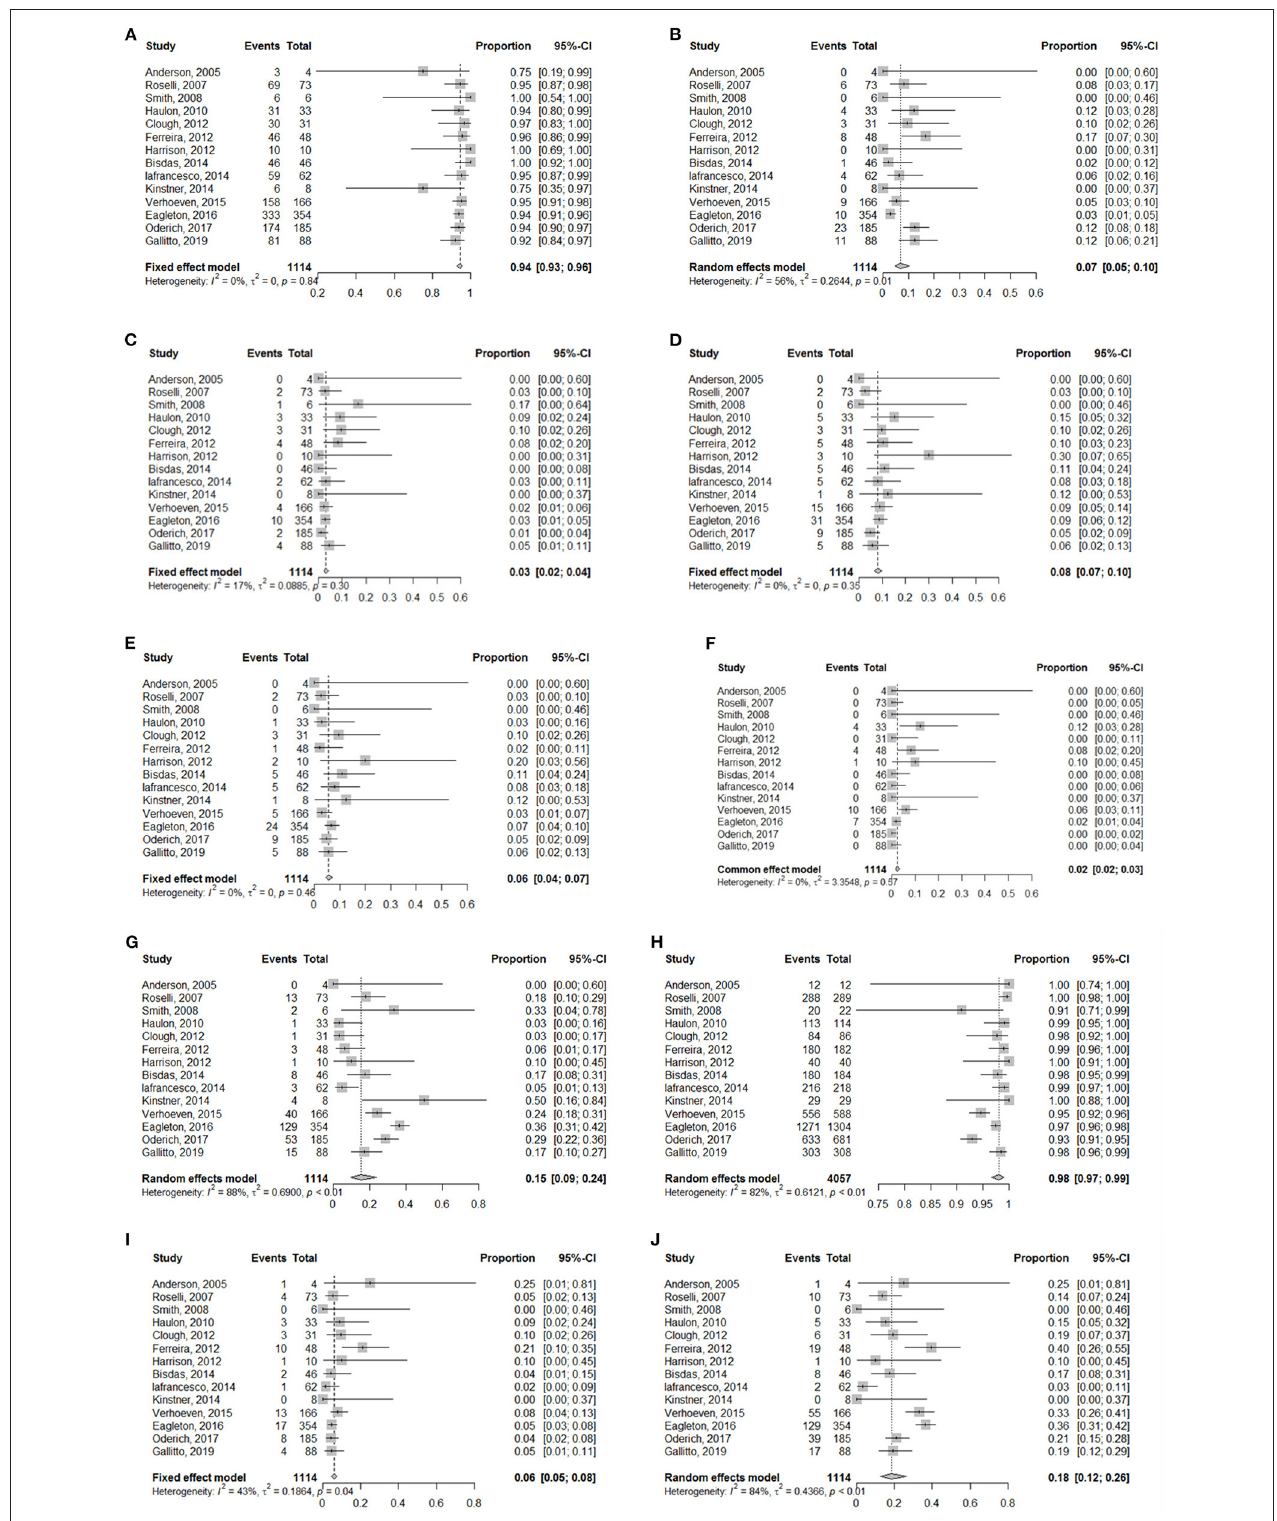
FIGURE 2 | Forest plots for (A) Technical success, (B) Renal insufficiency, (C) Dialysis, (D) SCI, (E) Irreversible SCI, (F) Reversible SCI, (G) Reintervention, (H) Target vessel patency, (I) 30-day mortality, (J) Overall mortality.